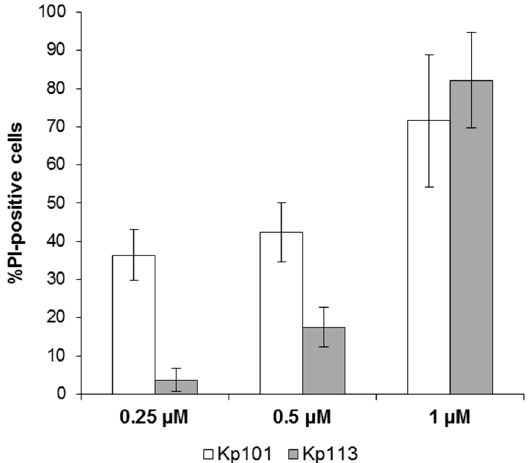
Figure 4. Evaluation of membrane damage induced by BMAP-27 in K. pneumoniae Ts101 and Ts113 strains. The percentage of damaged cells (% PI-positive cells) of KpTs101 and KpTs113 strains after 30 min incubation is reported as a function of BMAP-27 concentration. Bacterial cells (1 × 10 6 CFU/mL) were incubated for 30 min with peptide; propidium iodide (PI) was added to each sample to final concentration of 10 µg/mL and analyzed by flow cytometry. Data are expressed as the mean ± SD for three independent experiments.